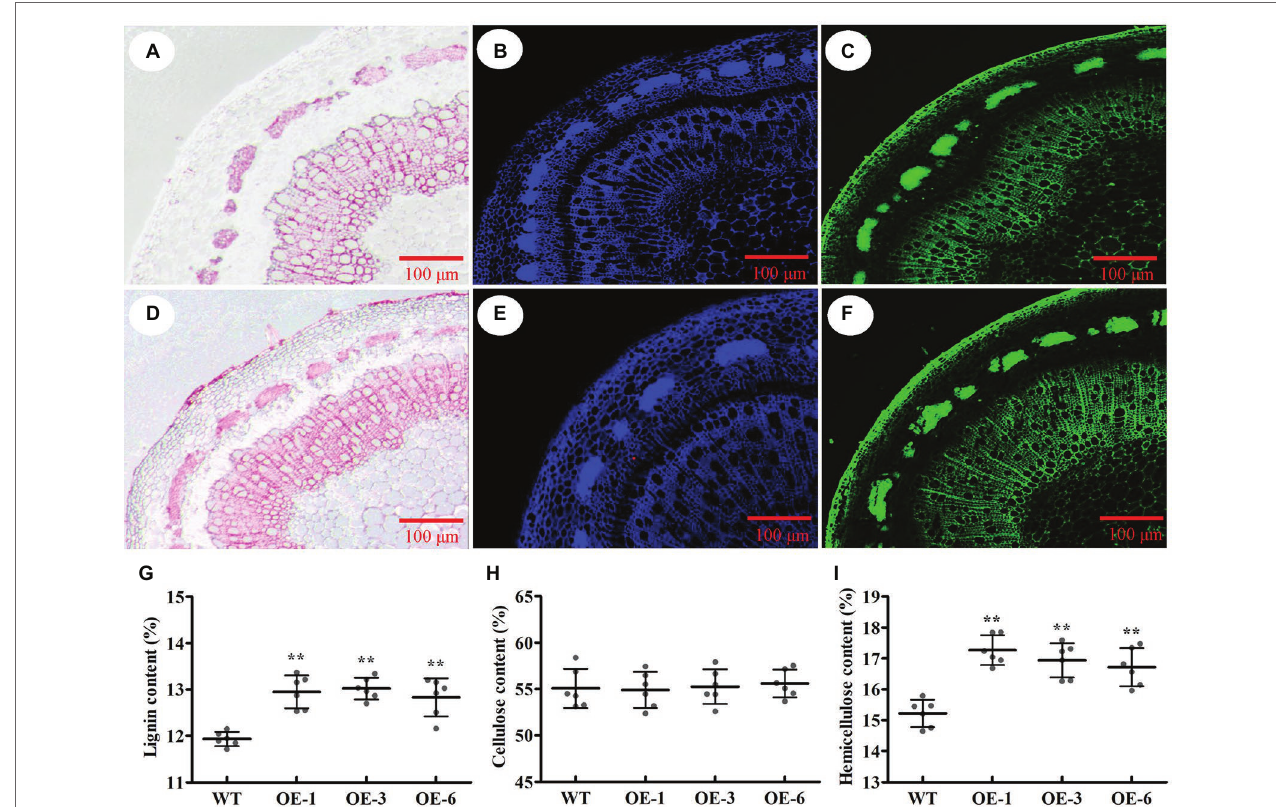
FIGURE 6 | Effects of PtrGATA12 overexpression on components of secondary cell wall of stems in P. trichocarpa . (A,D) Phloroglucinol-HCl staining (red color) stem sections of 90 days old wild-type (A) and PtrGATA12 transgenic lines (D) . (B,E) Calcofluor white staining (blue color) stem sections of wild-type (B) and PtrGATA12 transgenic lines (E) . (C,F) Monoclonal antibody LM10 (green color) stem sections of wild-type (C) and PtrGATA12 transgenic lines (F) . Scale bars = 100 μ m. (G) The lignin content of stems in WT and PtrGATA12 transgenic lines (OE-1, OE-3, and OE-6). (H) The cellulose content of stems in WT and PtrGATA12 transgenic lines. (I) The hemicellulose content of stems in WT and PtrGATA12 transgenic lines. Error bars represent SD of three biological replicates. Asterisks indicate levels of significance (Dunnett’s test; **, p <